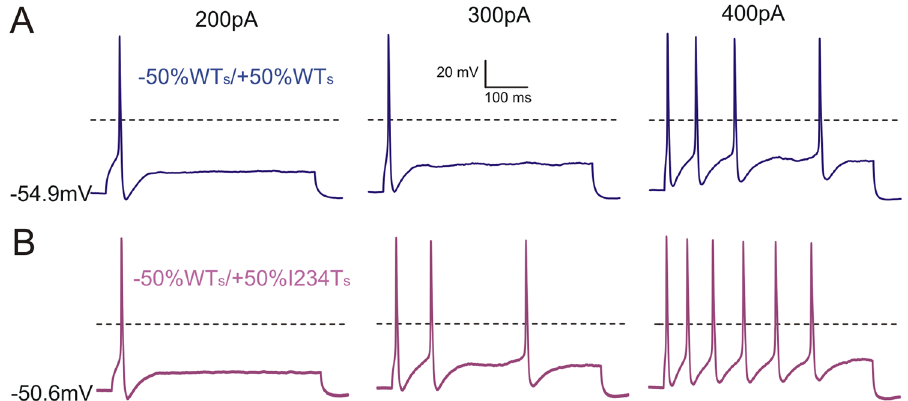
Figure 7. Injecting simulated I234T conductance using dynamic-clamp results in hyperexcitability in some native DRG neurons. The cell shown here initially had an RMP of − 56.8 mV. Replacing 50% of WT Na v 1.7 conductance with WT s ( A ) depolarized RMP by 1.9 mV while introducing 50% I234T s ( B ) depolarized RMP by 6.2 mV. In response to 500 ms current stimuli of 200 pA, a single action potential was evoked in the presence of either WT s or I234T s conductance. Introduction of I234T s produced hyperexcitability in the same cell, manifested as increased numbers of action potentials in response to 300 pA and 400 pA current